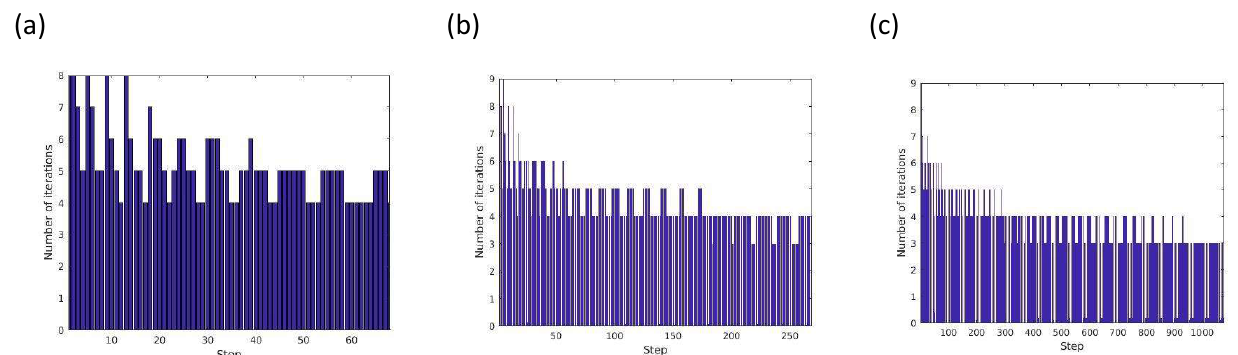
Figure 3. Number of iterations needed for the present method to reach the convergence criterion: ( a ) 20 × 20, ( b ) 40 × 40, ( c ) 80 × 80.